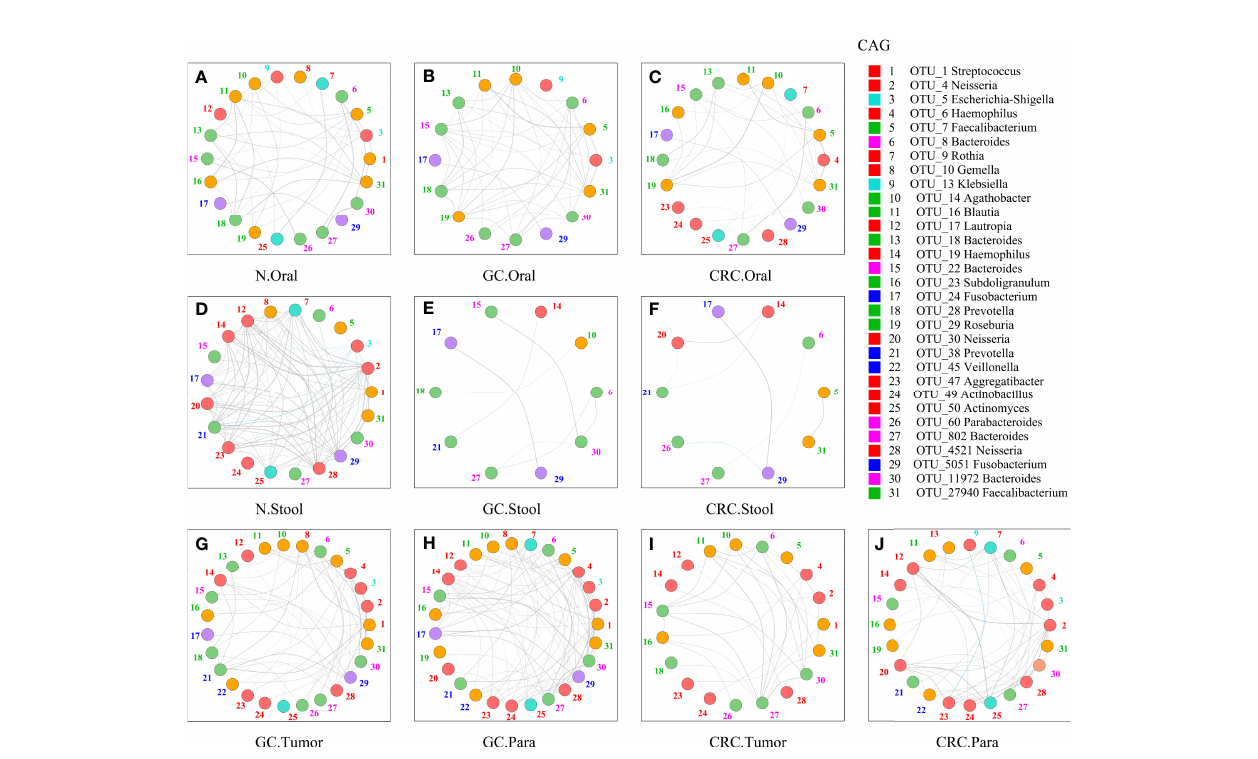
FIGURE 8 | Network analysis of microbiota shared by tumor, paracancerous tissue, oral cavity, and stool in HC, GC, and CRC. The fi gure showed the 31-OTU ( Figure 6 ) network map of bacteria found in the oral, fecal, tumor, and paracancerous mucosal microbiota of HC, GC, and CRC participants: oral samples of 70 HC (A) , 70 GC patients (B) , and 42 CRC patients (C) ; fecal samples of 70 HC (D) , 49 GC patients (E) , and 33 CRC patients (F) ; tumors from 33 GC patients (G) and 24 CRC patients (I) ; and paracancerous tissue of 36 GC patients (H) and 24 CRC patients (J) . For each group of samples, OTUs shared with oral and fecal samples were determined respectively. The color of each nodule was divided according to its phylum, and the color of the number (the corresponding OTU) beside the nodule was only calculated using the corresponding CAG in Figure 6 ( Figures 6A, D ). The colors of the lines between nodes (Spearman correlation value: r > 0.6 or < − 0.6, p < 0.01) were divided according to correlation (gray: positive correlation, blue: negative correlation). As the Spearman correlation value between each corresponding node increased, the width of each edge increased. Legend on the right: the Mothur method and the SSUrRNA database of SILVA138 were used to perform species annotation analysis on OTUs sequences. OTU_1 was shared by Bio fi lm CAG and Proteobacteria CAG and shown in